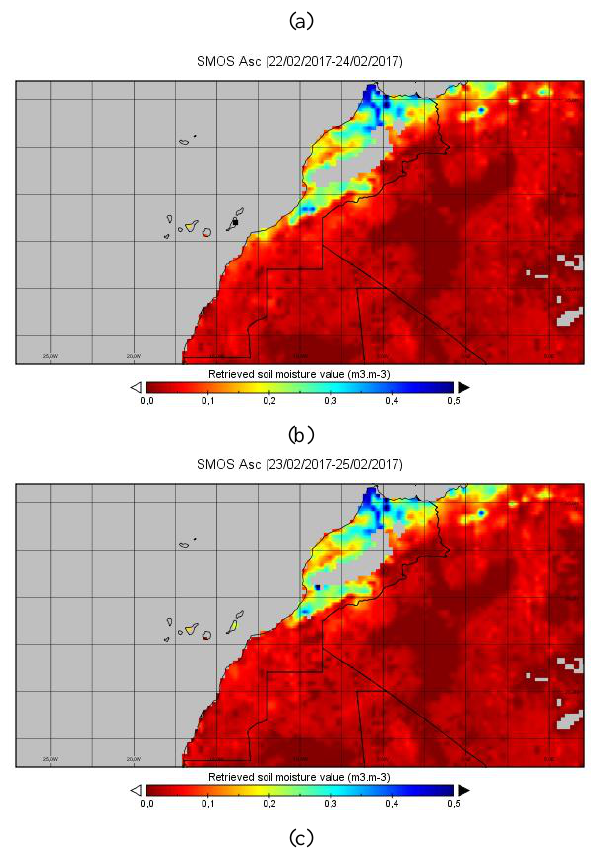
Figure 9. SM maps before (a), during (b) and after (c) the flood event